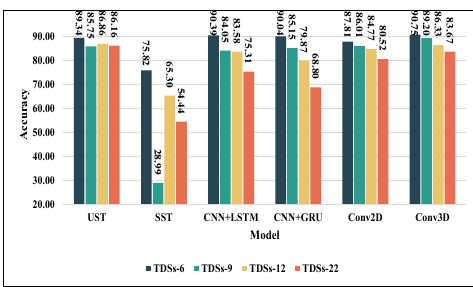
Figure 17. Recognition accuracies and their variations of six backbones on four task datasets.